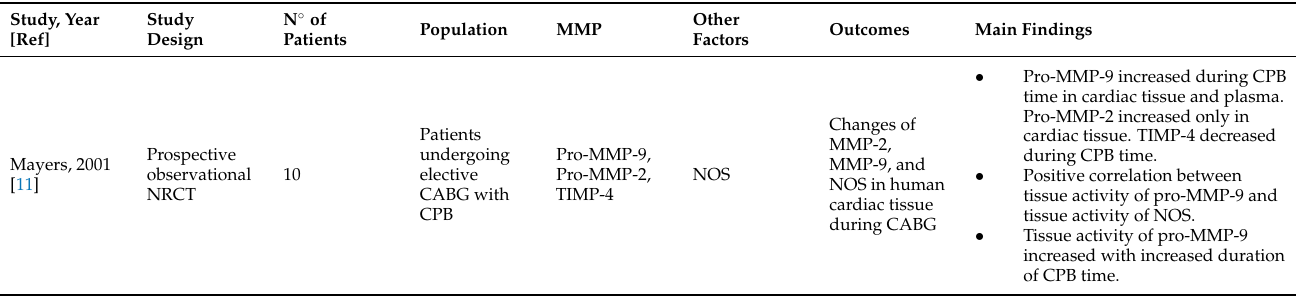
Table 1. Key characteristics of individual studies. Abbreviations: AKI, acute kidney injury; CABG, coronary artery bypass graft; CPB, cardiopulmonary bypass; IL, interleukin; LCN-2, lipocalin-2; MMP, metalloproteinase; NRCT, non-randomized controlled trial; NOS, nitric oxide synthase; RCT, randomized controlled trial; TIMP, tissue inhibitors of metalloproteinases; TNF α , tumor necrosis factor α ; TxB2, thromboxane